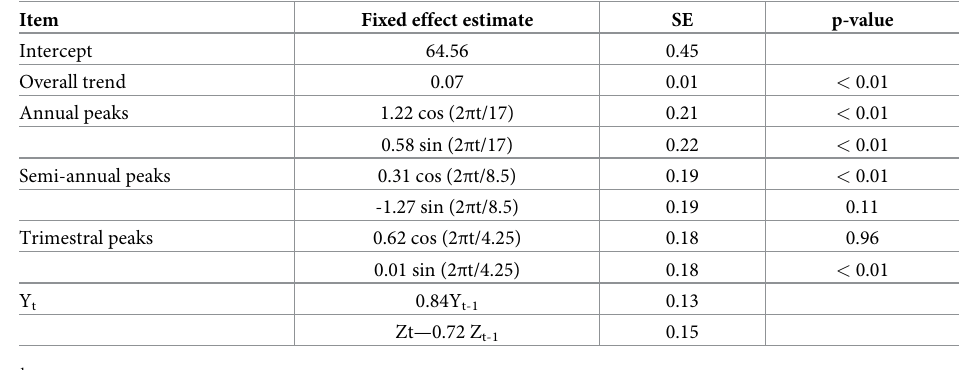
Table 2. Final autoregressive integrated moving average (ARIMA) model 1 used to evaluate presence of seasonal peaks in insemination risk in large dairy herds located in